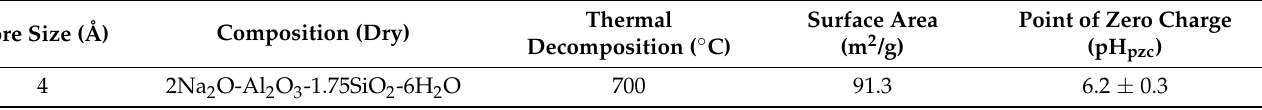
Table 1. Properties of Fe-zeolite Catalyst.